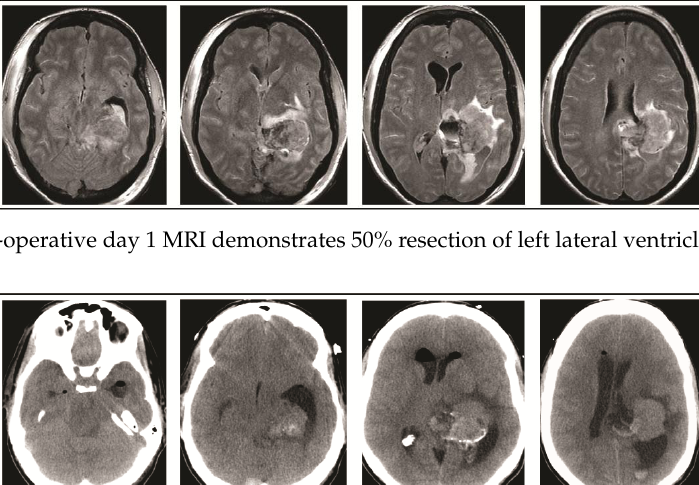
Figure 2. Post-operative day 1 MRI demonstrates 50% resection of left lateral ventricle meningioma.